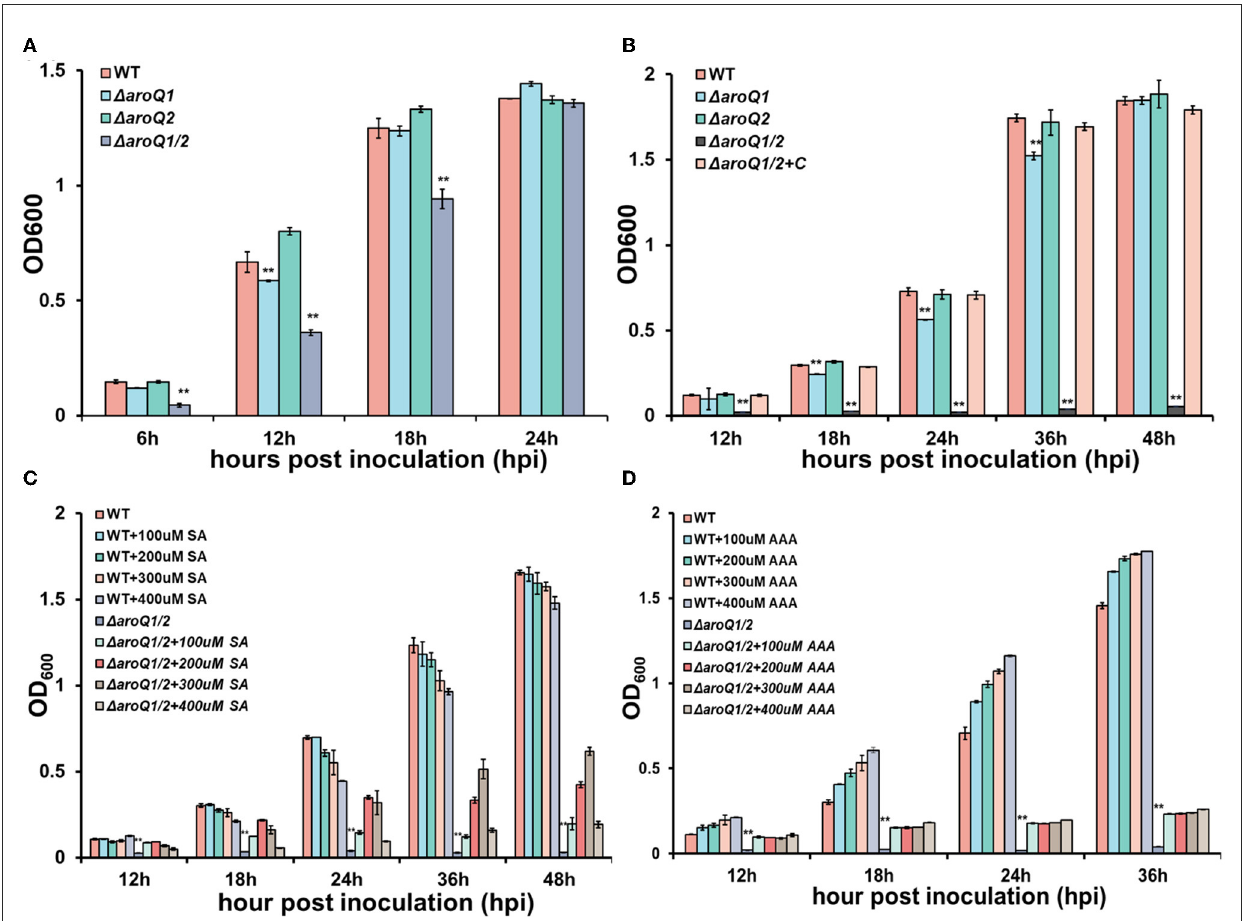
FIGURE1 Involvement of AroQ in the growth of R. solanacearum OE1-1 in (A) nutrient-rich medium, (B) nutrient-limited medium (Hoagland medium with 2% of sucrose, minimal medium), (C) minimal medium with supplementary shikimic acid (SA) and (D) minimal medium with supplementary AAA of L-Phe, L-Tyr, and L-Trp. WT, RK5050 (OE1-1, popA-lacZYA ); 1 aroQ1 , RQ5920 (RK5050, 1 aroQ1 ); 1 aroQ2 , RQ5908 (RK5050, 1 aroQ2 ); 1 aroQ1/2, RQ5951 (RK5050, 1 aroQ1/2, deletion of both aroQ1 and aroQ2 ); 1 aroQ1/2 + C, and RQC1634 (RQ5951 with complementary aroQ1 ). For the growth assay in medium, cell suspension (washed two times with distilled water) was adjusted to an OD 600 of 1.0 and inoculated into fresh media with a proportion of 1%, and OD 600 was measured periodically. For supplementation with SA acid and AAA, SA, and AAA (L-Phe, L-Tyr, and L-Trp) were added into the minimal medium at moderate concentrations. Each assay was repeated with three biological replicates including three replicates per trial, and mean values of all experiments were averaged with standard deviation (error bars). Statistical significance between the double mutant (RQ5951) and RK5050 was assessed using a post-hoc Dunnett’s test following the analysis of variance. Significance level ** indicates P <